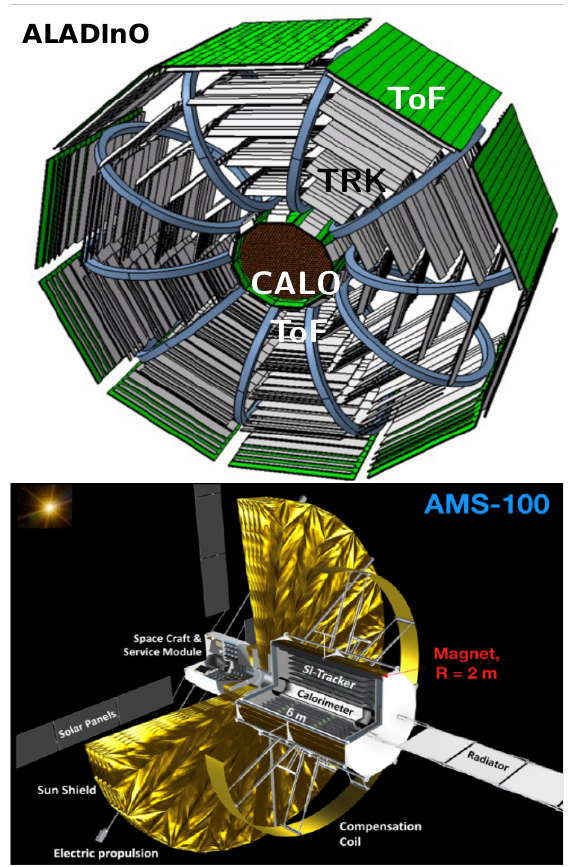
Figure 16. Graphical rendering of the baseline design for the ALADInO [36] (top) and AMS-100 [35] (bottom)